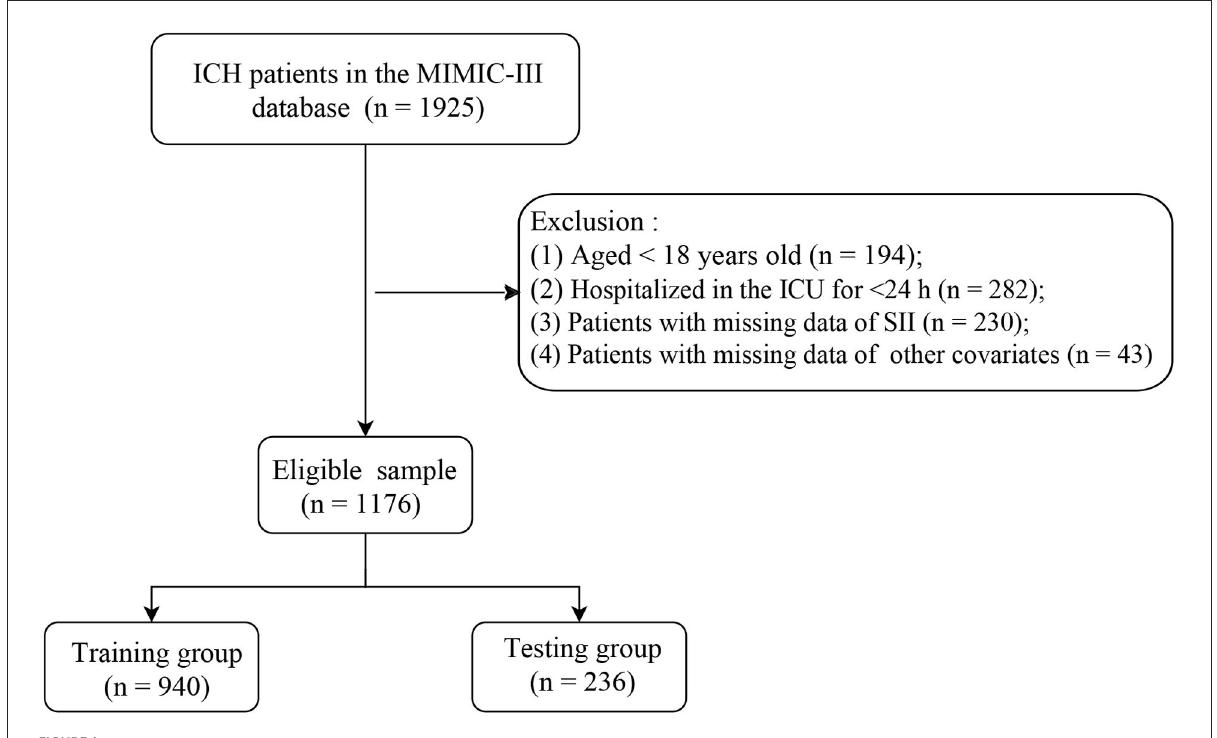
FIGURE1 A flow diagram of the